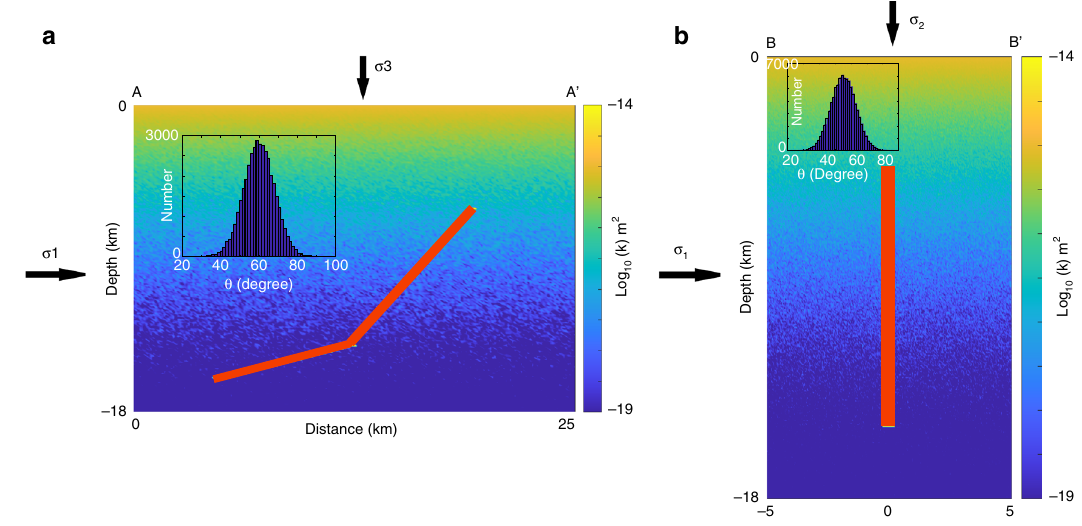
Fig. 2 Model setup and initial conditions. Model setup for ( a ) Northridge and ( b ) all Landers and Hector Mine simulations, showing an initial overpressure embedded within the shown background permeability fi eld. The positioning of the two-fault Northridge simulation was determined by the cloud of aftershocks in cross-section, and all other simulations were centered in the middle of the pro fi le. The red indicates the initial zone of overpressure, and set at 70 MPa above hydrostatic. Inset histogram shows the orientation of virtual slip planes measured from the normal to σ 1 (taken as twice σ 3 = ρ gz), where ρ is rock density, g is gravity acceleration, and z is